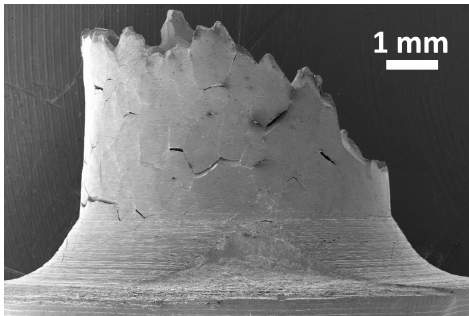
Figure 4: The side view of a 9 ppm S specimen, tensile tested at 750 °C at 8 × 10 − 5 s − 1 . Considerable secondary cracking is observed. A specimen 6 mm in diameter was used here (instead of 3.5 mm) to better evidence the grain boundary nature of the secondary cracks.